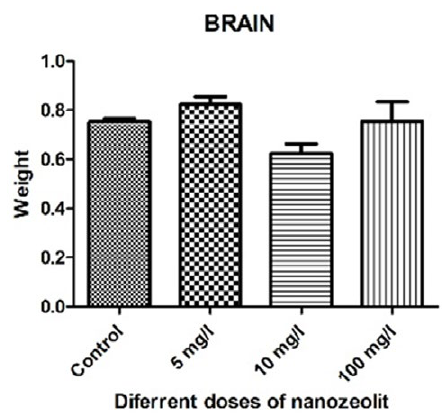
Fig. 4. increased the embryos weight significantly at Fig. 6. elevated the brain weight at the dose of 5 the dose of 5mg/L Fig.3. increased the embryos weight significantly at the dose of 5mg/L Fig.5. elevated the brain weight at the dose of 5 mg/L